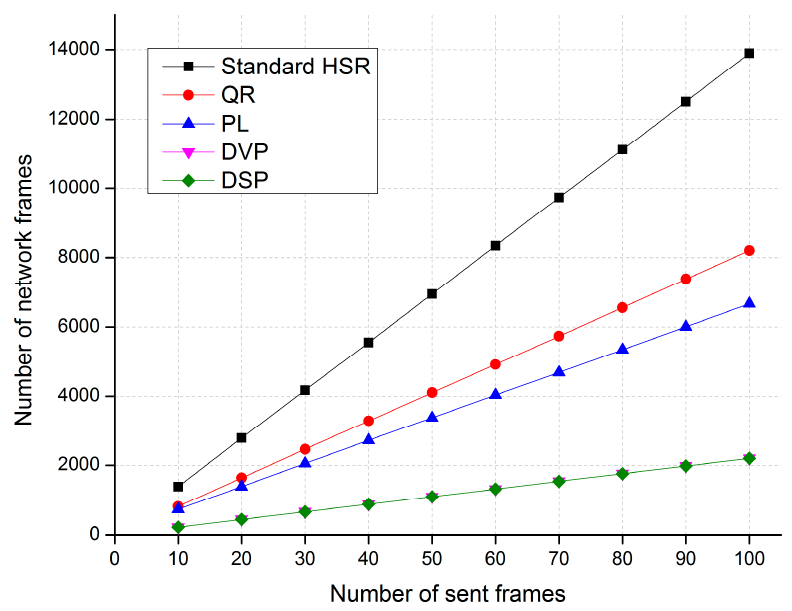
Figure 12. A comparison of traffic performance in Case 2.